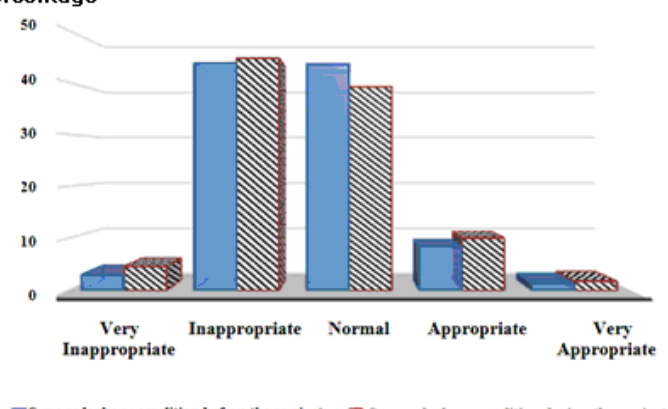
Fig. 5: Sewage leakage situation in the study area before and during project Table 3: The reputation of the neighborhood before and after the start of the project for residents The reputation of the neighborhood after the project The reputation of the neighborhood before the project Rank Reputation